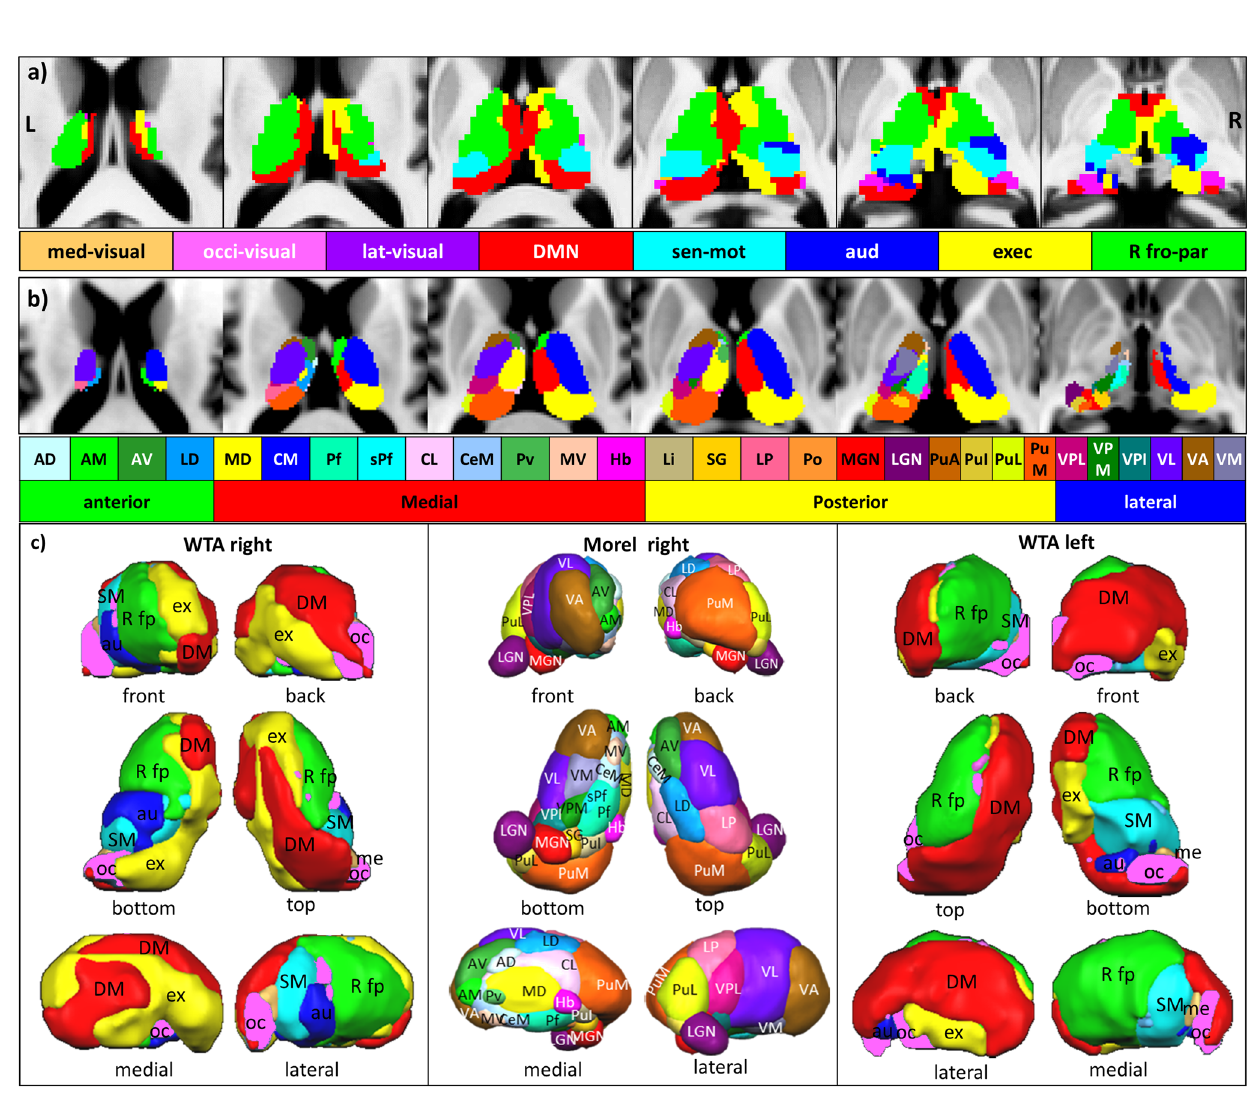
Fig. 5 Winner-takes-it-all (WTA) maps. a WTA maps of the right and left thalamus on six axial slices and b corresponding slices from the histology atlas of the thalamus. c 3D rendered views of WTA maps of the left and right thalamus in comparison with right thalamic nuclei of the atlas of Morel. The networks are depicted in their different colors. The color assignments in hex color code: MV (FDCB6E), OV (FA70FC), LV (971B99), DMN (FA141B), SM (3CFEFE), AU (002CFB), EX (FFFC38), RF (41FB30), LF (6A971B). The nuclei depiction is color-coded with respect to each nucleus. The detailed color assignments in hex color code: AD (CBFFFF), AM (41FB30), AV (359430), LD (1AA0FC), MD (FFFC38), CM (002CFB), Pf (3FFDB6), sPf (3CFEFE), CL (FDCAFE), CeM (98C9FD), Pv (52B755), MV (FDC8AC), Hb (F933FC), Li (C0B47F), SG (FECE30), LP (FA6897), Po (FC963F), MGN (FA141B), LGN (711172), PuA (C56419), PuI (DCC642), PuL (DCFC36), PuM (FA571F), VPL (C2187B), VPM (1C7F13), VPI (177877), VL (612DFB), VA (965B15), VM making-risk, and response-inhibition-control. The Rfro and Lfro midline as well as lateral nuclei groups. The Rfro topic maps are functional network correlated topic maps show a rather variable response-inhibition-control, control-con fl ict-task, memory-work- overlap with the thalamus and the topic maps. However, the Rfo ing-wm, and pain-somatosensory-stimulation. In contrast, Lfro displays an overlap with almost all the nuclei. In contrast, Lfro topic-maps are the language-reading-word and frequency-hz-ms. network topic-maps overlap with the anterior, intralaminar, In contrast to the combined topic maps, separate topic maps